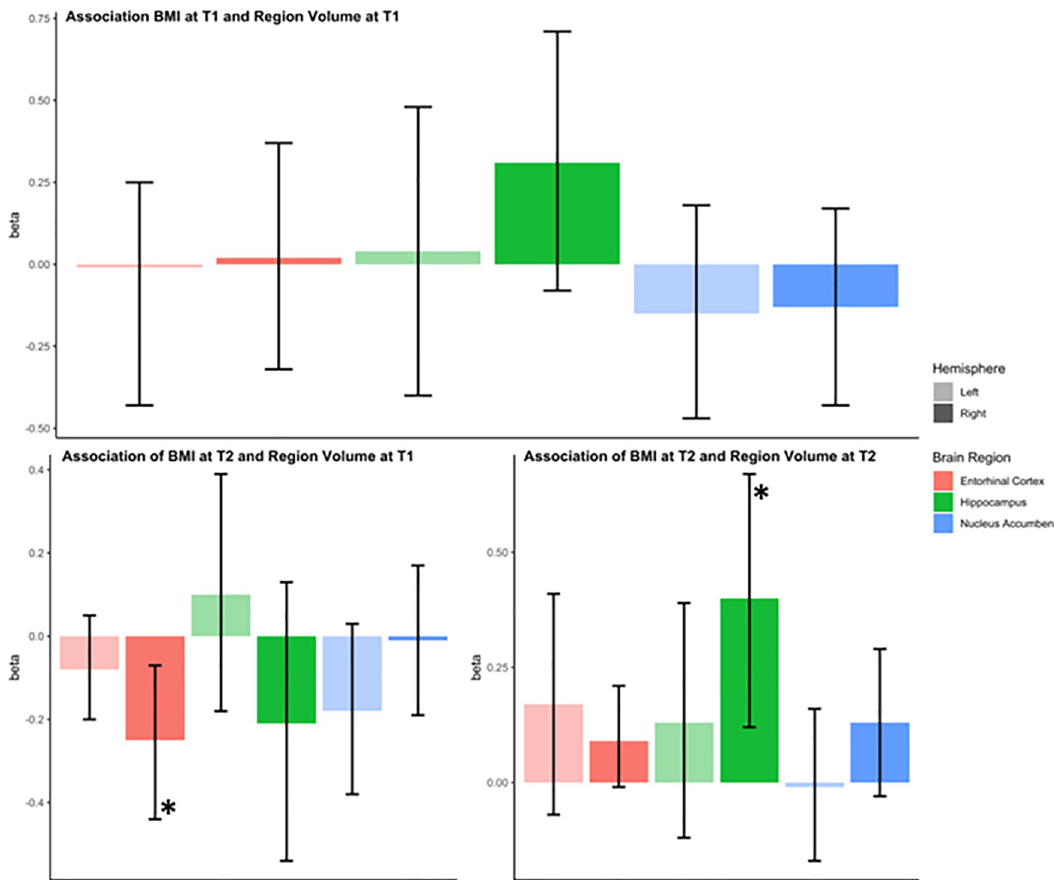
Fig 2. Graphical representation of the beta values derived from the structural equation model (SEM) for each brain region of interest. Error bars indicate 95% confidence interval. T1 = Baseline; T2 = 1 Year Follow Up. � indicates p < 0.05.